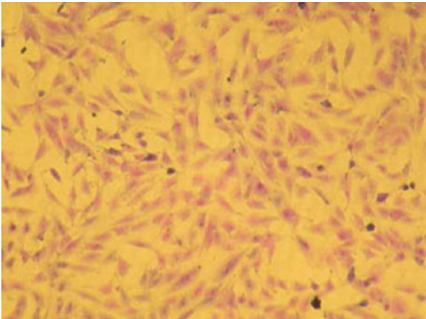
Figure 3: Morphology of mouse embryo fibroblasts in the cell proliferation experiment carried out by the direct contact method in the presence of PAA-DD as lactate ammonium salt [33].